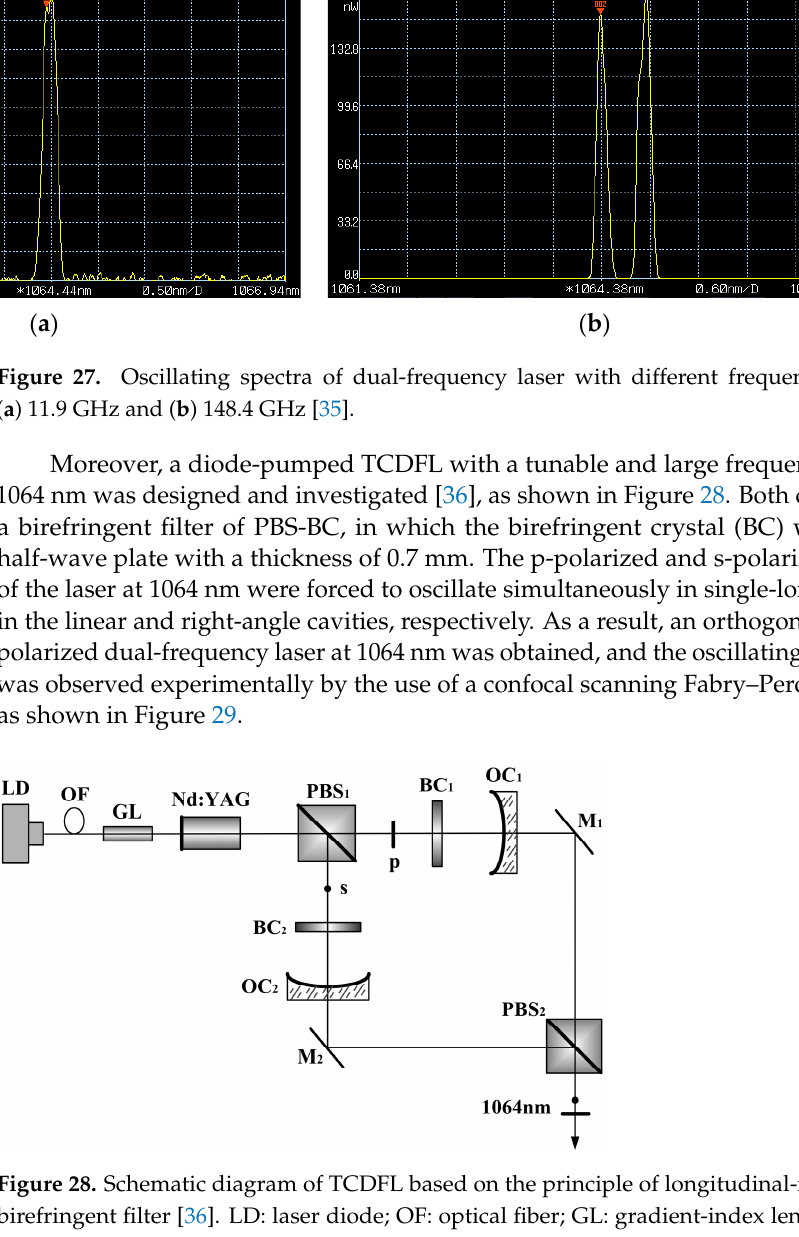
Figure 28. Schematic diagram of TCDFL based on the principle of longitudinal-mode selection by birefringent filter [36]. LD: laser diode; OF: optical fiber; GL: gradient-index lens; PBS: polarizing bean splitter; BC: birefringent crystal; OC: output coupler; M: mirror.